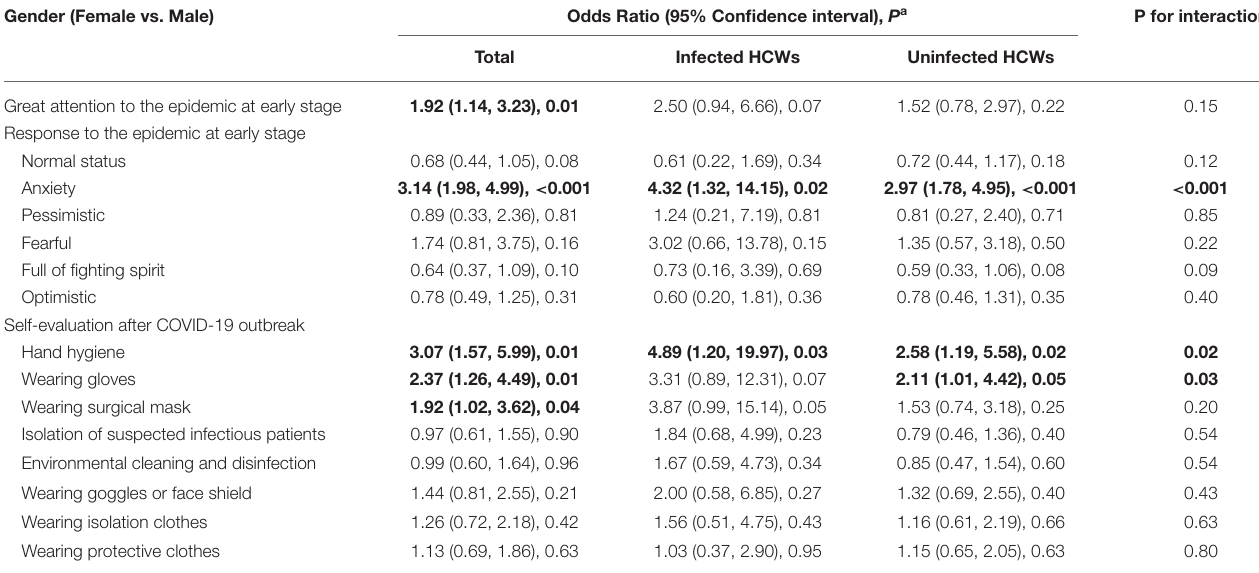
TABLE 3 | Adjusted effect of gender on facing conscious and self-evaluation on protective measures using Firth’s multivariable logistic regressions. Gender (Female vs.